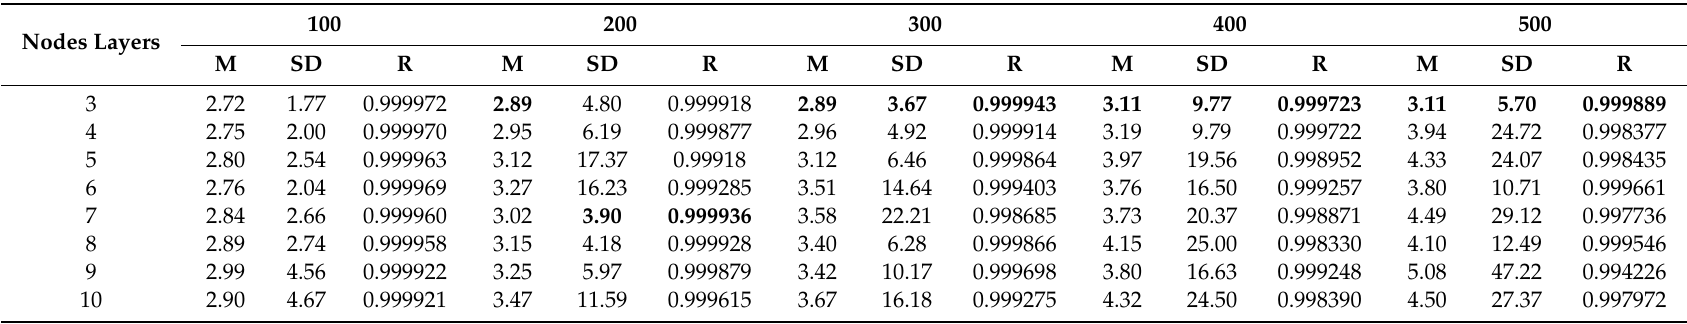
Table 2. Summary of the retrieval errors for obtaining the FAI. (M: mean error, R: correlation coe ffi cient, and SD: standard deviation of the fit). The actual value of M and SD are the value in the table times 10 − 3 . For all columns, the minimum M with maximum R and minimum SD is indicated in bold. Nodes